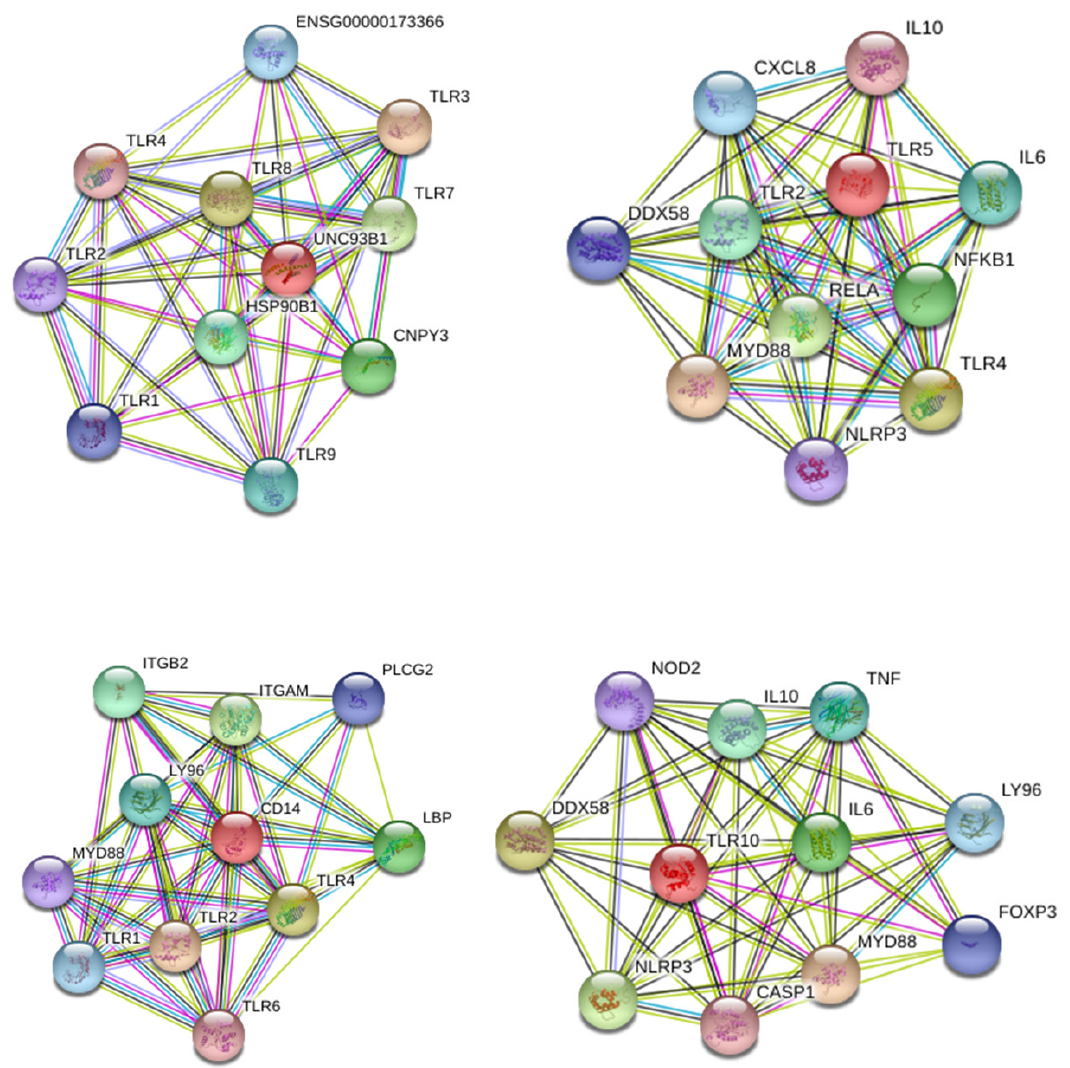
Figure 7. STRING 11.0 analysis of known and predicted TLR-protein interactions. The interactions include direct (physical) and indirect (functional) associations. Network nodes represent proteins and edges represent protein-protein associations (specific and meaningful). The lines represent the existence of the several types of evidence used in predicting the associations (high confidence score 0.9). The interactions are shown in different colors: black is co-expression; dark blue is co-occurrence; purple is experimental evidence; light green is text mining.